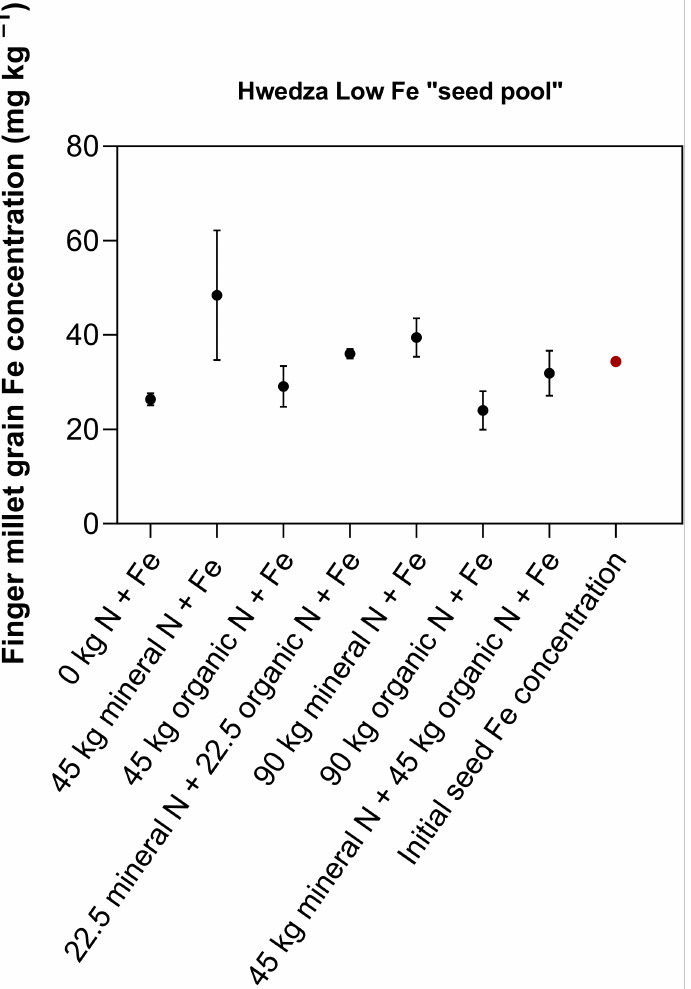
Figure 5. Mean grain Fe concentration of the low Fe finger millet “seed pool” receiving different forms and rates of N and Fe fertilizer in Hwedza District. Bars represent ± SEM. The red point represents the initial seed Fe